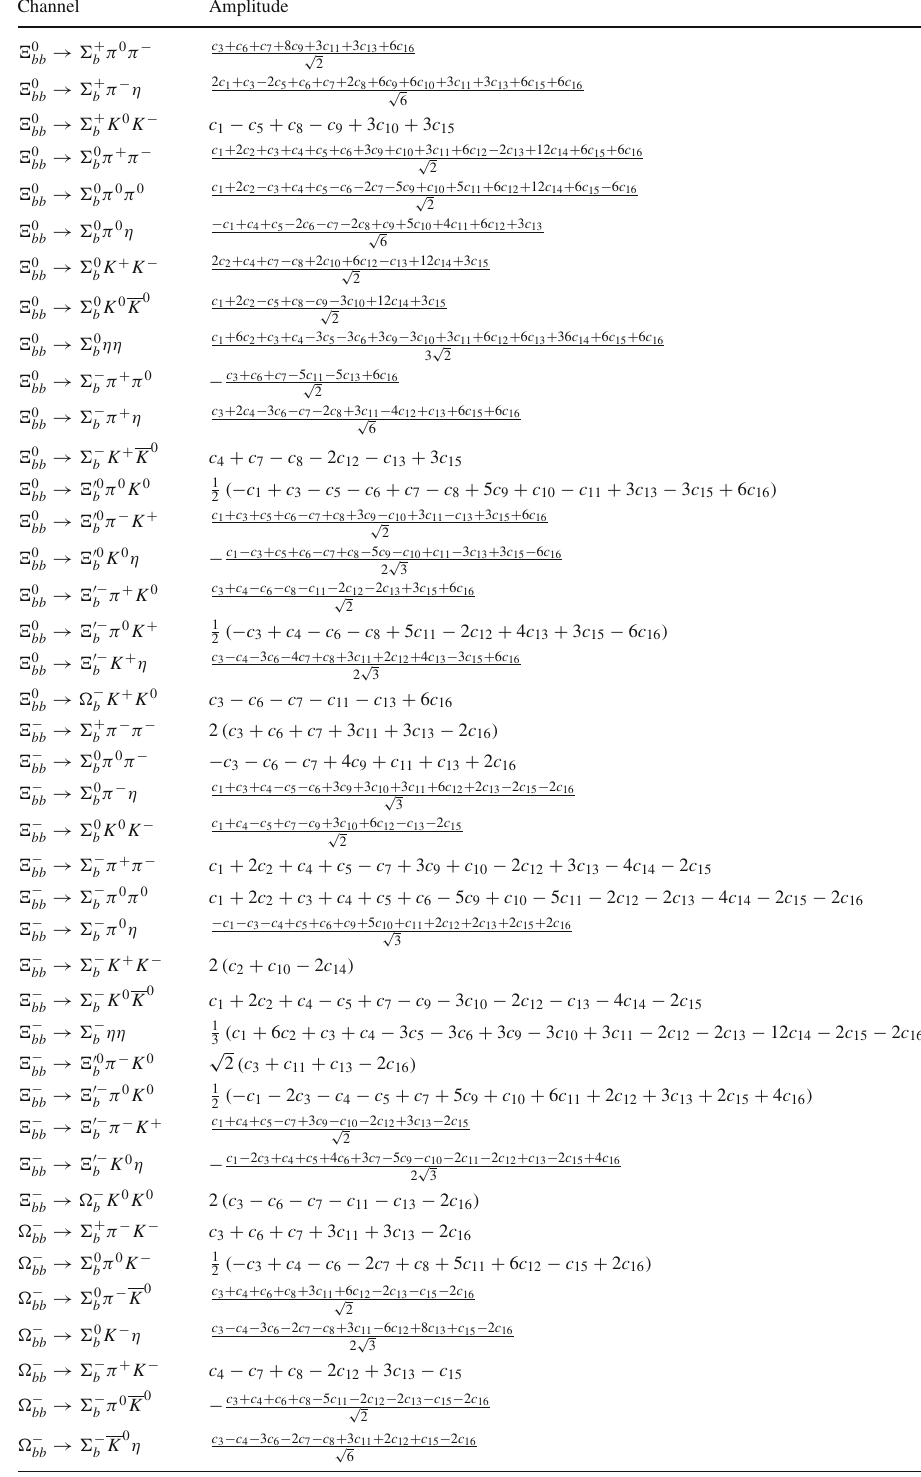
Table 24 Doubly bottom baryon decays into a bqq (sextet) induced by the charmless b → d transition and two light mesons